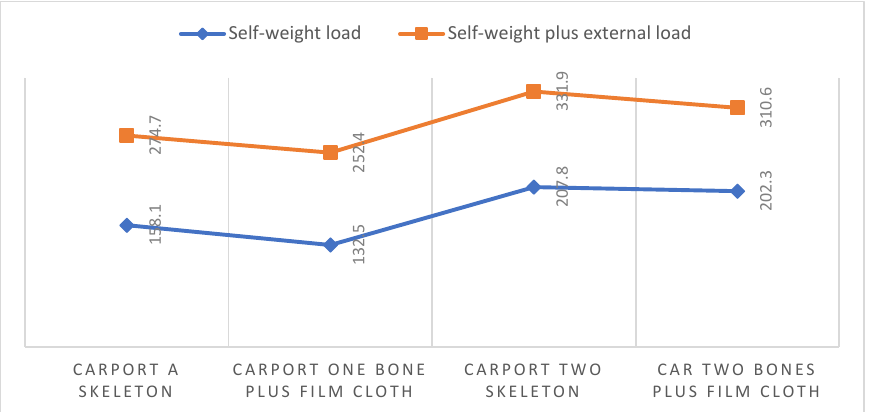
Figure 29. Folding line diagram of combined displacement of two carports under self-weight and self-weight plus an external load. The data in the figure are obtained from the simulation results of finite element software.